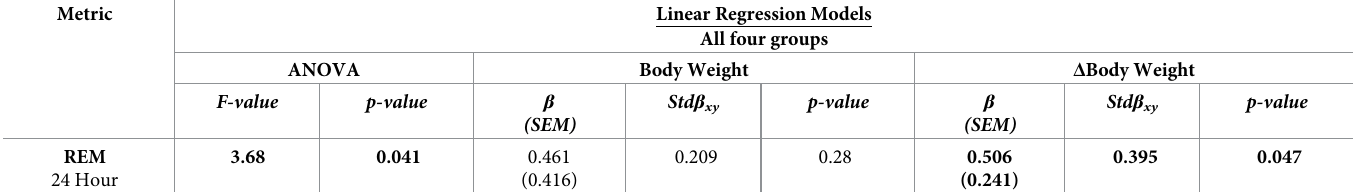
Table 3: p = 0.10). Third, caloric intake and total REM sleep are positively related to Δ